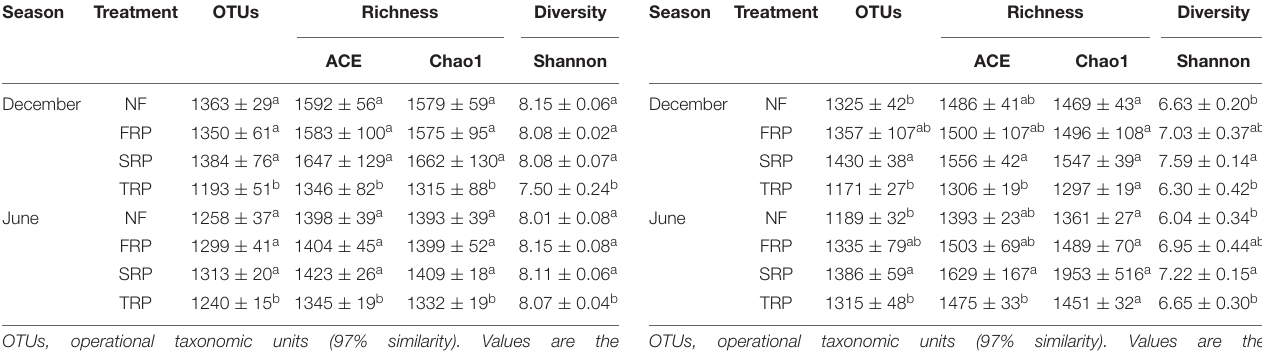
TABLE 3 | Soil fungal alpha diversity indices in December and June at the Xinkou Forest Farm, Fujian, China. Season Treatment